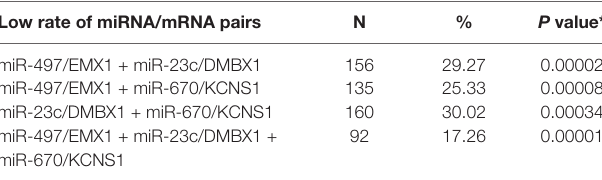
TABLE 2 | Patients with the simultaneous presence of low rates of miRNA/ mRNA